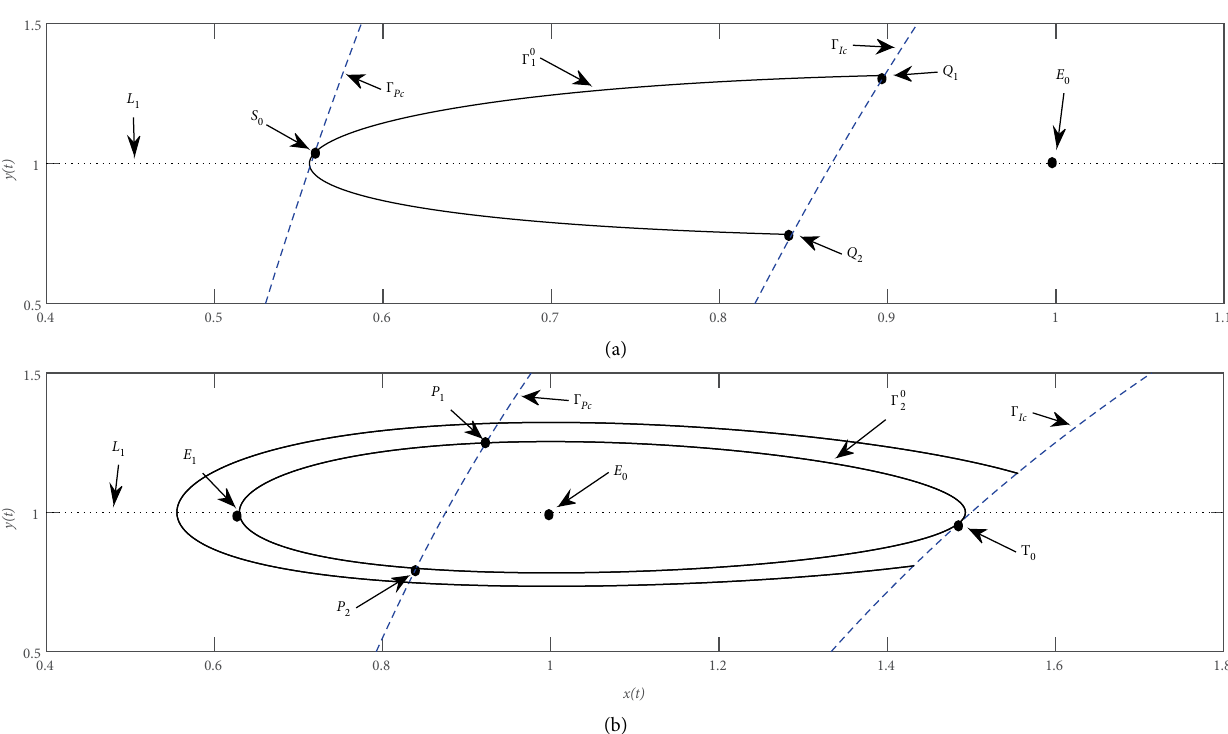
Figure 2: Illustration diagrams of the impulsive and phase sets for model (8). (a) tangent to curve